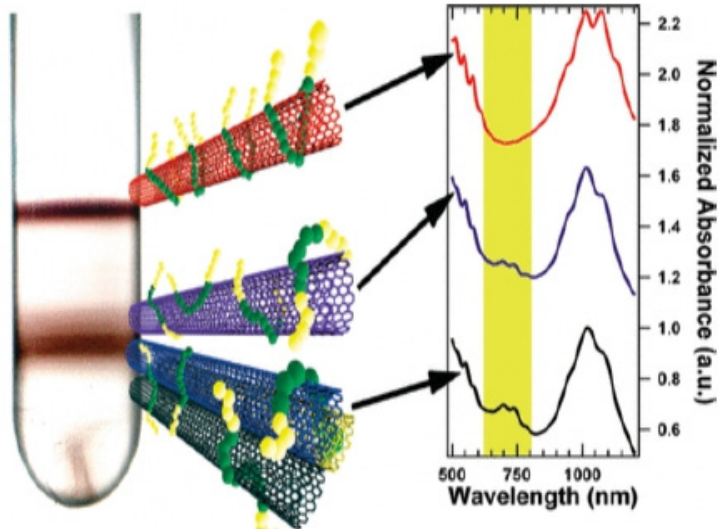
Figure 8. Centrifuge tubes after DGU separations using Pluronic F108 (top) and Pluronic F68 (middle) are shown in pictures. Optical absorbance spectra of the SWNTs that were extracted in the centrifuge tube at the locations shown by arrows [188]. The colors of CNTs represent their color in suspension.